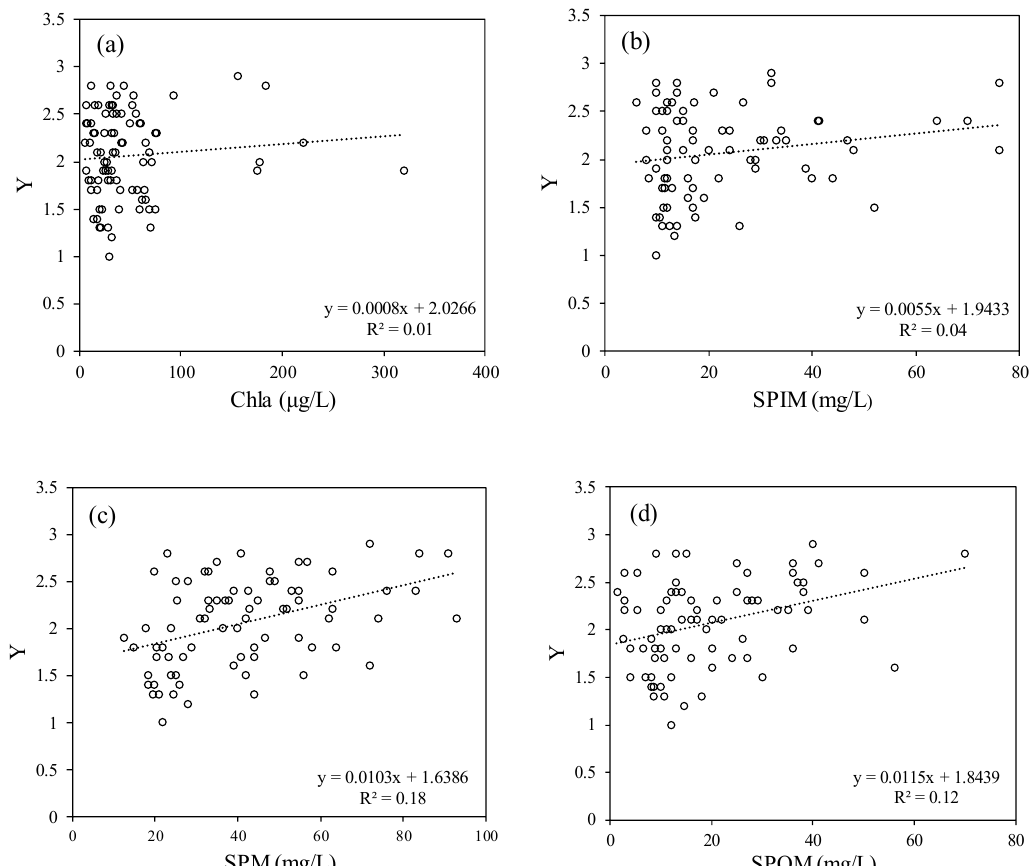
Figure 5. Relationships between Y values and the following water quality parameters, based on measured data: ( a ) chlorophyll-a (Chl a ), ( b ) suspended particulate inorganic matter (SPIM), ( c ) suspended particulate matter (SPM), and ( d ) suspended particulate organic matter (SPOM).